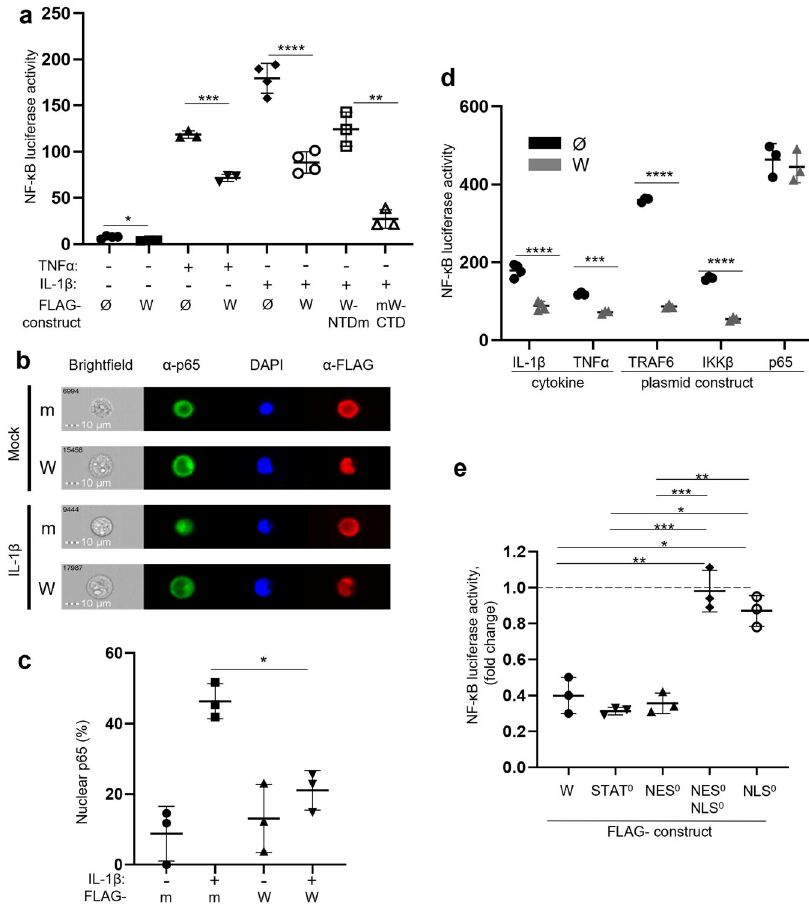
Fig. 2 W inhibits the canonical NF- κ B pathway downstream of IKK β by a mechanism depending on its nuclear import and inhibits nuclear accumulation of p65. a HeLa cells were transfected with a NF- κ B_luc plasmid together with either an empty vector (Ø) or plasmids encoding FLAG-tagged W protein variants. Transfection with Renilla luciferase was used for normalizing the results. Cells were stimulated 20 h after transfection with 10 ng/mL of TNF α or IL-1 β for 4 h prior to measurement of NF- κ B activity by luminescence quanti fi cation. b , c HeLa cells were transfected with FLAG-mCherry (m) or FLAG-tagged W (W) protein encoding plasmid and stimulated or not with 10 ng/mL IL-1 β for 20 min. Cells were immunostained for NF- κ B p65, FLAG, and DAPI, and the percentage of cells displaying nuclear localization of p65 was determined using ImageStreamX. d Cells were transfected with an empty vector (Ø) or a plasmid encoding the FLAG-tagged W protein and stimulated with either IL-1 β or TNF α as detailed for a , or stimulated by transfection with a plasmid encoding either TRAF6, IKK β , or NF- κ B p65. e Cells were transfected with the NF- κ B_luc vector together with the indicated plasmids encoding FLAG-tagged W protein or variants of it harboring disabled STAT1/4-binding site, NES, and/or NLS indicated as STAT 0 , NES 0 , NES 0 NLS 0 , and NLS 0 , respectively, and stimulated 20 h after transfection with 10 ng/mL of IL-1 β . The data were expressed as the fold change of the signal observed with the empty vector (dotted line). NF- κ B activity was assessed by luminescence quanti fi cation. The data represent mean values of three independent experiments showed as mean ± SD. Pairwise comparisons were carried out using a Student ’ s t -test and multiple comparisons were performed using one-way ANOVA completed by a Tukey ’ s multiple comparisons test (* p < 0.05, ** p < 0.01 *** p < 0.001, **** p <